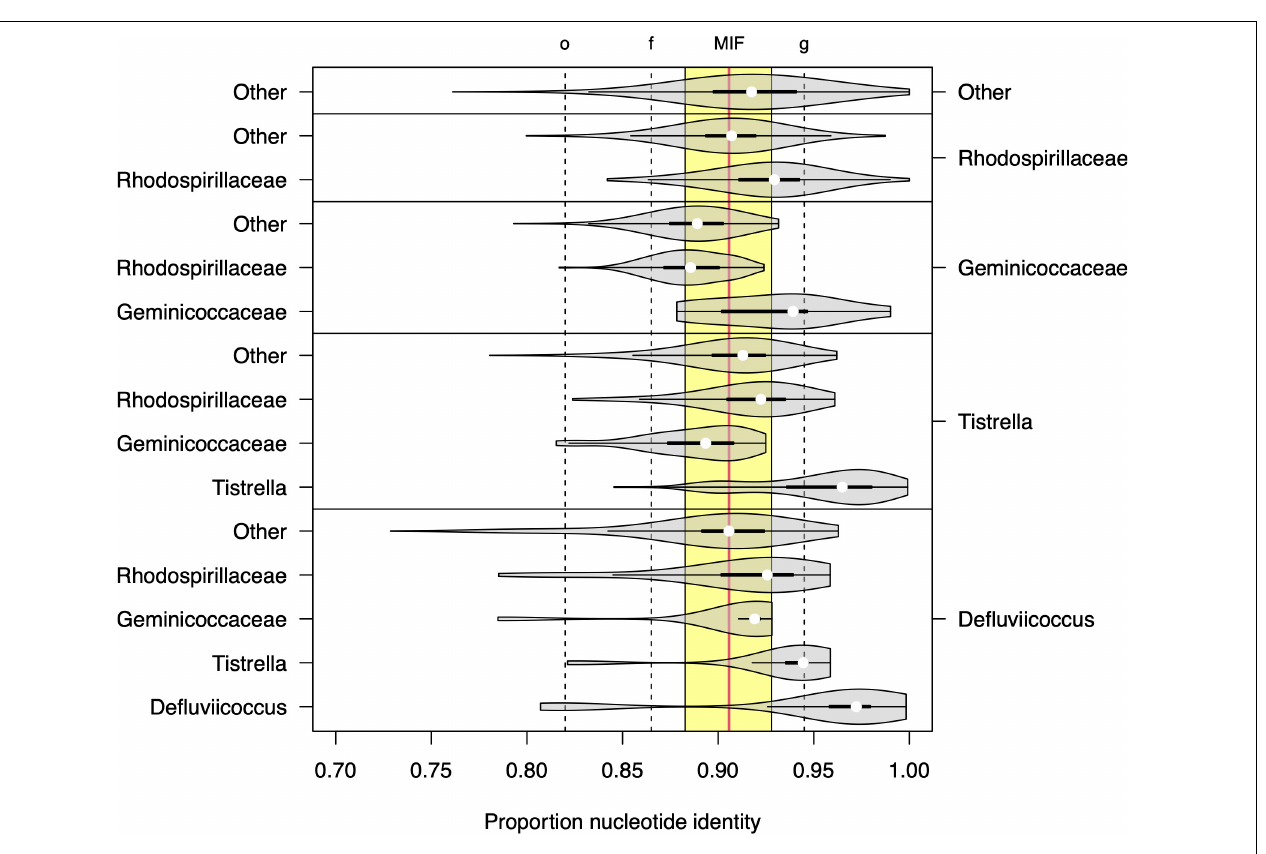
FIGURE 5 | Sequence identity statistics of full length 16S SSU-rRNA sequences among members of genera Defluviicoccus and Tistrella , the families Geminicoccaceae and Rhodospirillaceae , and other members of the order Rhodospirillales . Each violin plot shows the distribution of the proportion of nucleotide identity (PNI) between members of two microbial groups (listed on the right and left axes, respectively). The vertical dashed lines show the values of the minimal inclusion thresholds for different taxonomic levels (g, genus; f, family; o, order) defined by Yarza et al. (2014) and the yellow region delineates the range of mean PNI values from intra-family groups within order Rhodospirillales , with the overall mean shown as vertical solid red line (denoted as MIF: median